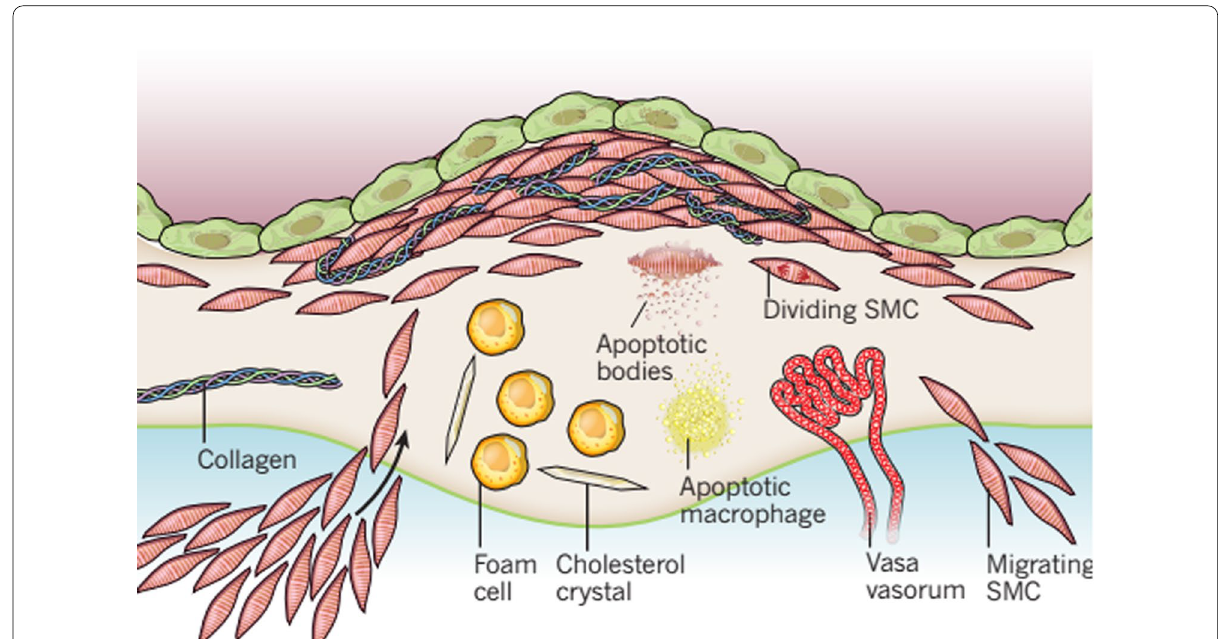
Fig. 3 Lesion progression. It involves the migration of SMCs from the media to the intima, the proliferation of resident intimal SMCs and media-derived SMCs, and the heightened synthesis of extracellular matrix macromolecules such as collagen, elastin and proteoglycans. Plaque macrophages and SMCs can die in advancing lesions, some by apoptosis. Extracellular lipid derived from dead and dying cells can accumulate in the central region of a plaque, often denoted the lipid or necrotic core. Advancing plaques also contain cholesterol crystals and